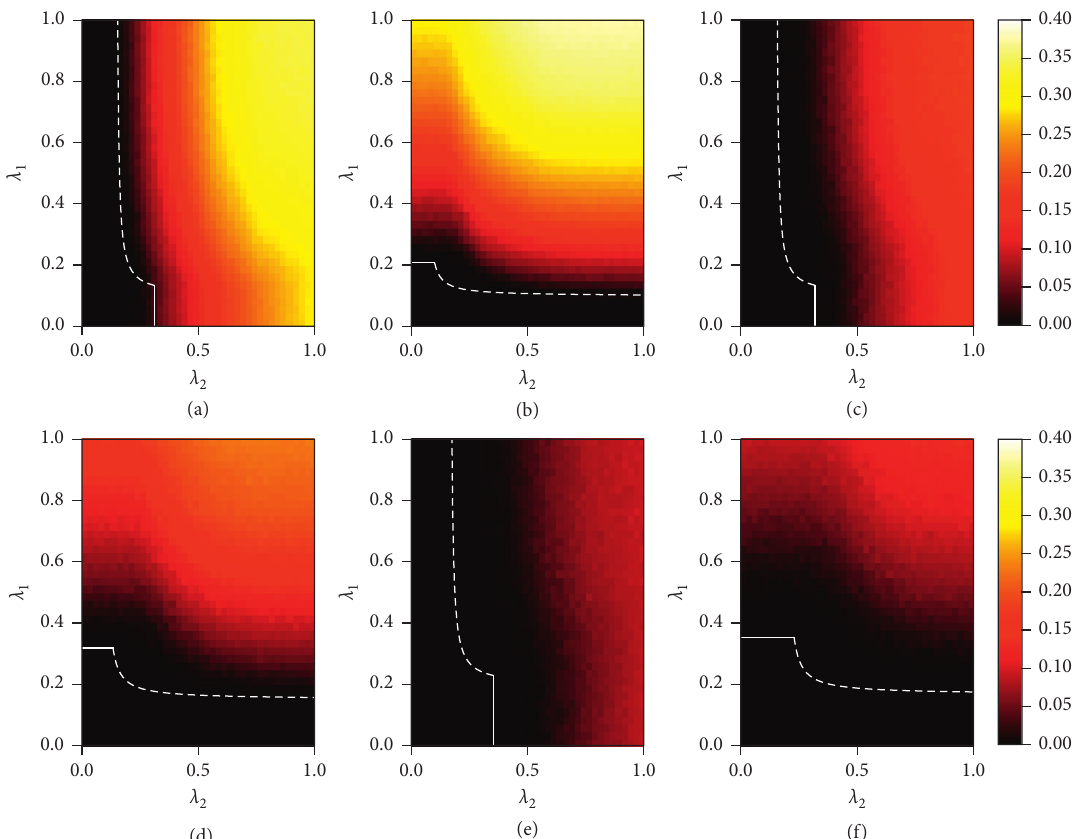
Figure 3: Product information diffusion mutual reinforcing